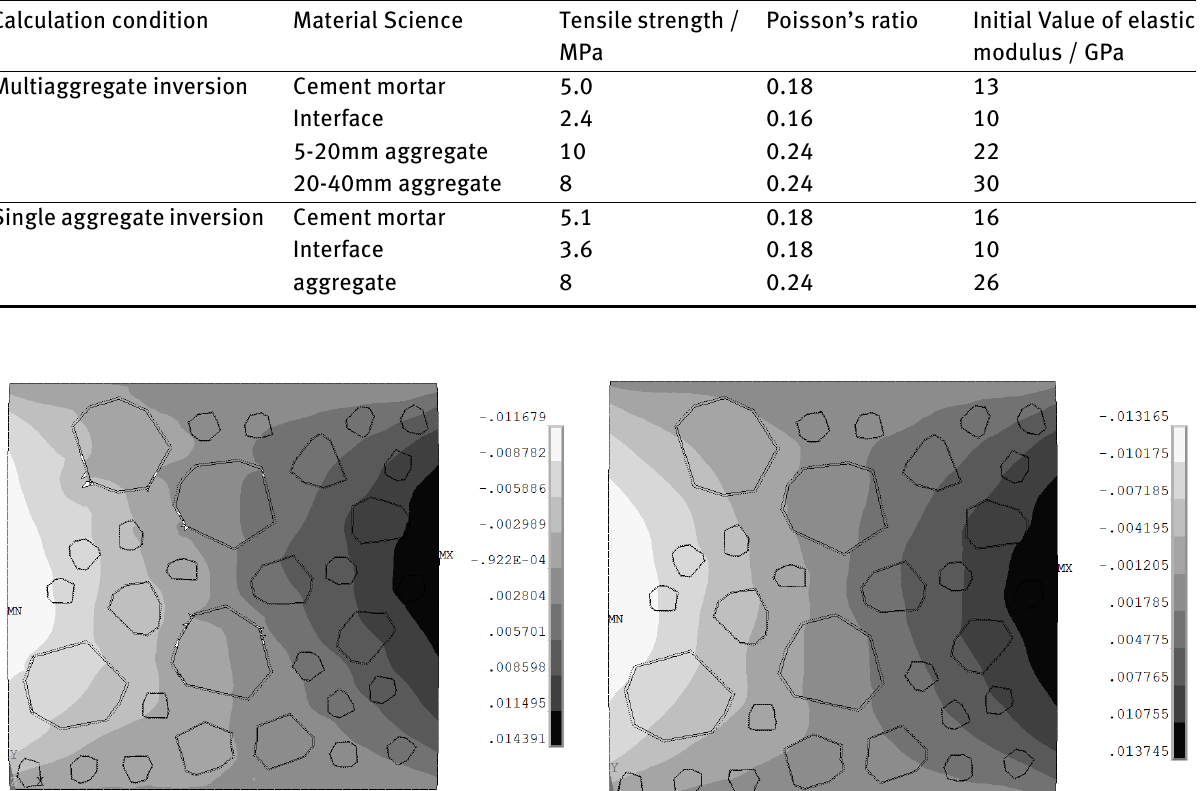
Due to the use of displacement control loading, the strain in the lab uniaxial compression test was